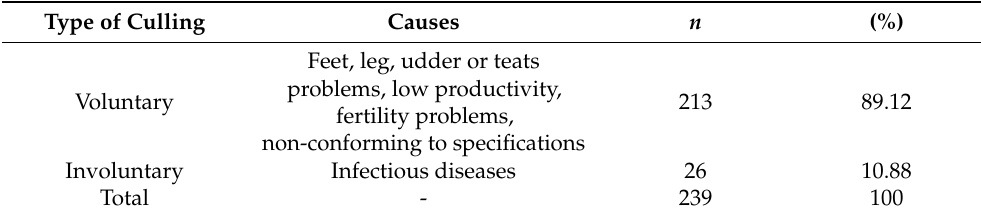
Table 2. Distributions of primiparous goats according to the different culling reasons.